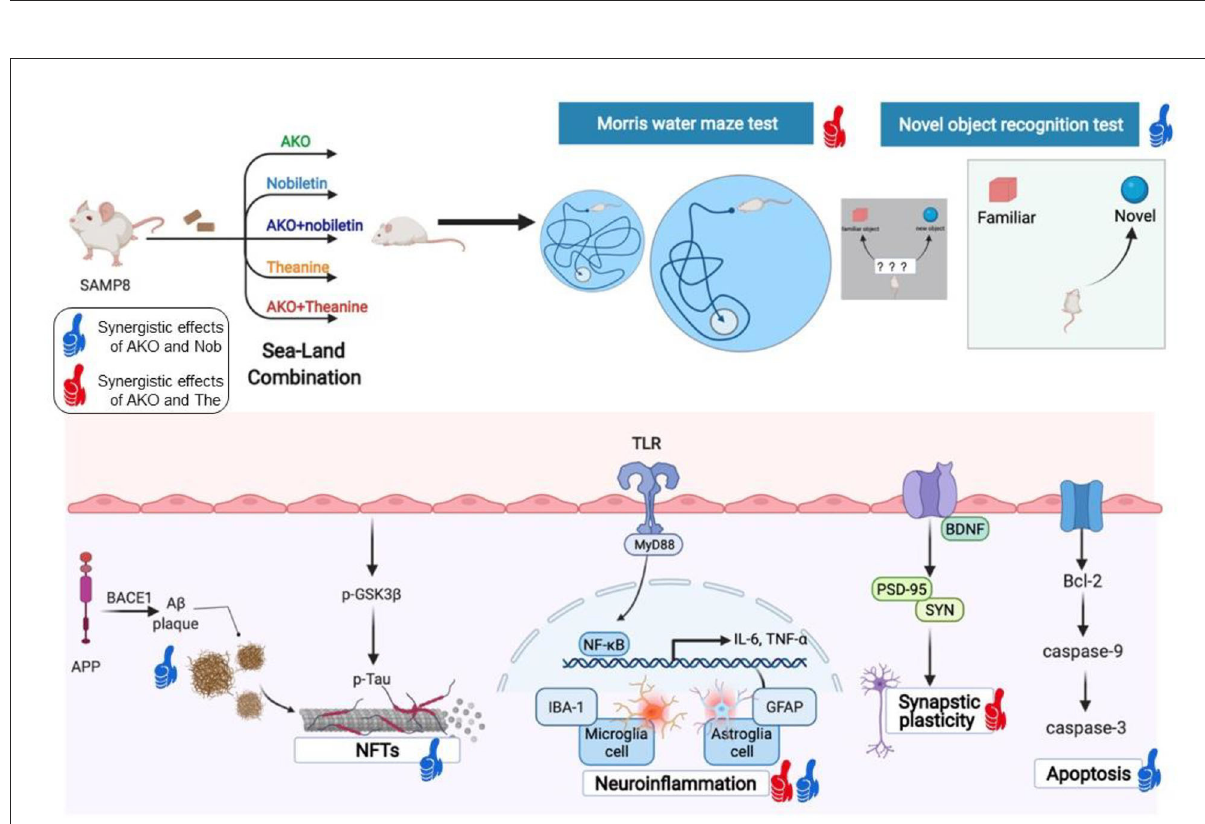
FIGURE8 The synergistic effects of Antarctic krill oil (AKO) with nobiletin (Nob) and theanine (The) in ameliorating memory and cognitive deficiency in senescence-accelerated prone 8 mice (SAMP8) mice. The synergistic effects of AKO with Nob were signed by blue thumb, and the synergistic effects of AKO with The were signed by red